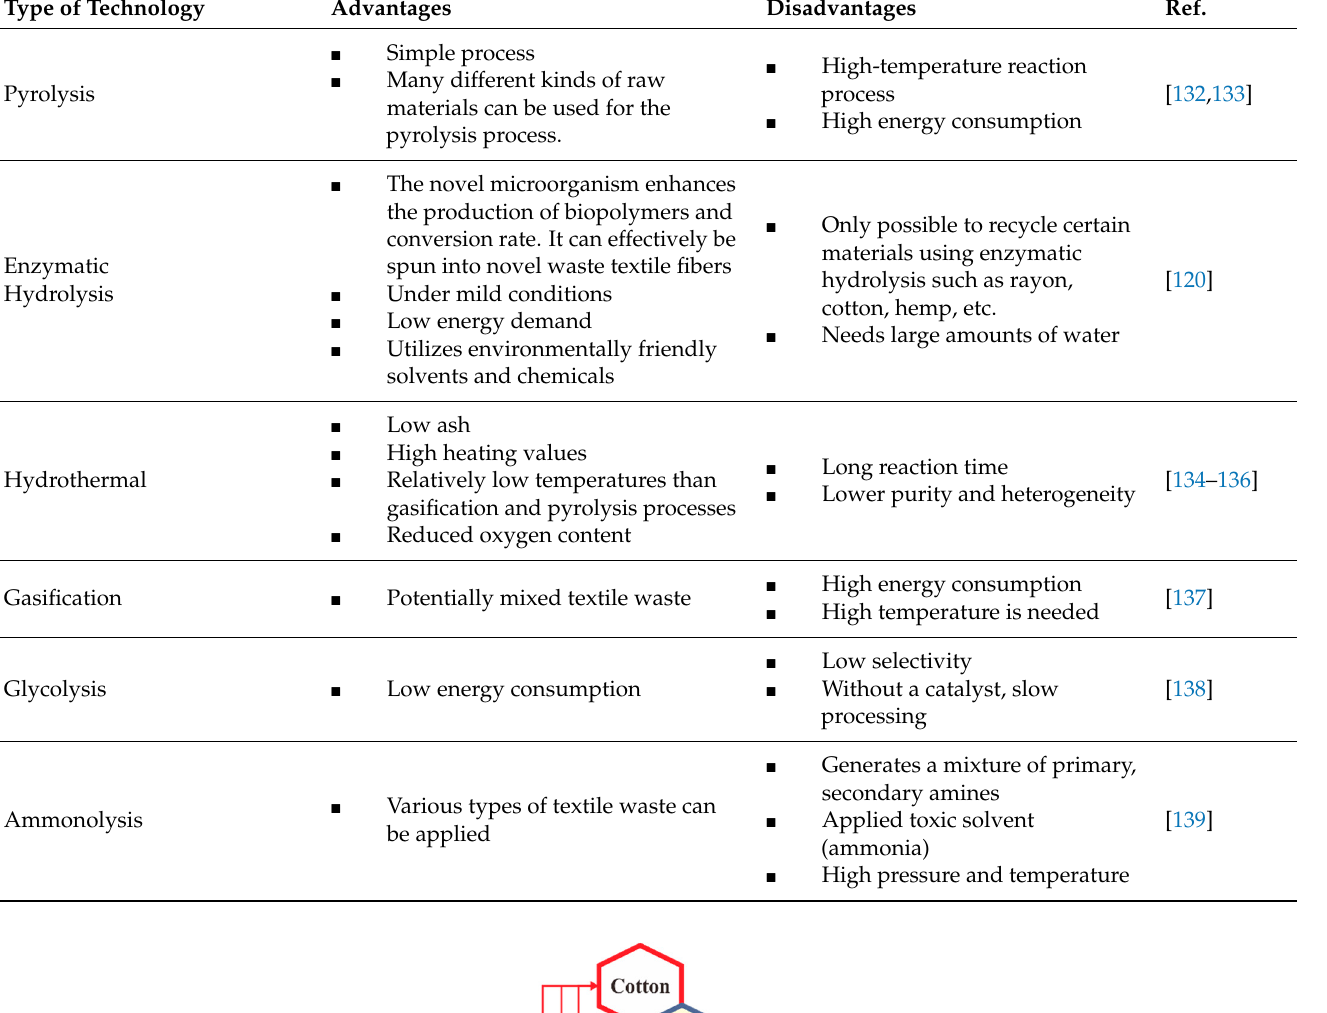
Table 3. The drawbacks, advantages, and disadvantages of chemically recycling textiles.